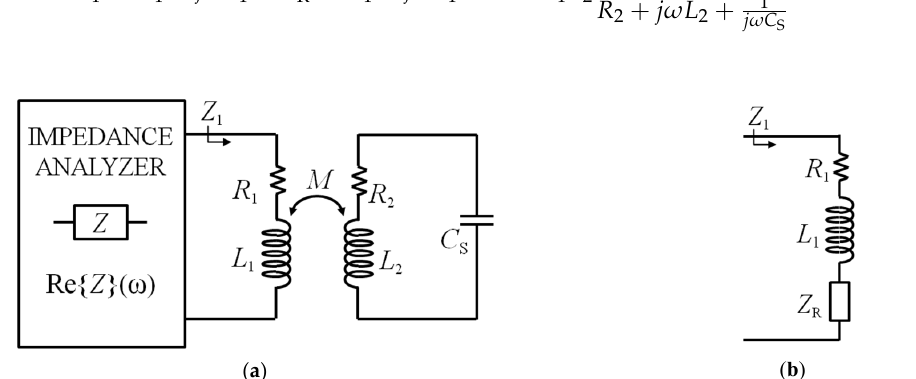
Figure 3. ( a ) Block diagram of the interrogation system based on impedance measurement from the primary coil; ( b ) equivalent circuit for the calculation of Z 1 . primary coil; ( b ) equivalent circuit for the calculation of Z 1